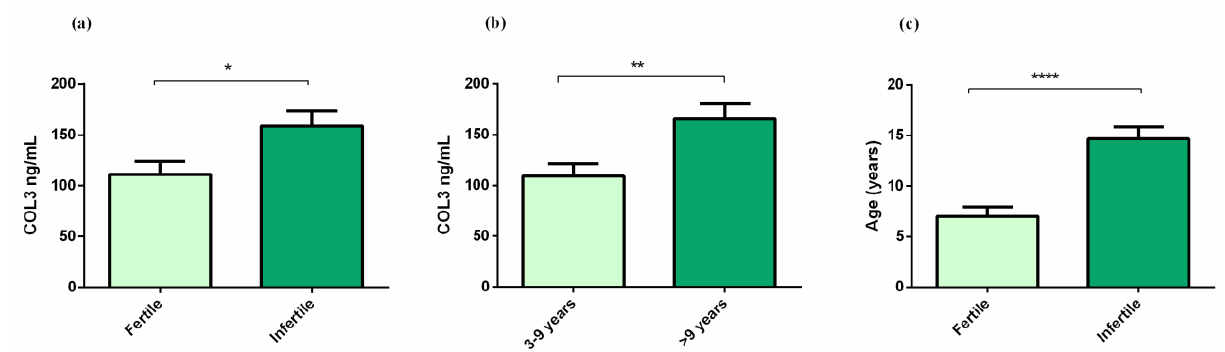
Figure 5. ( a ) Effect of fertility on serum type III collagen (COL3); ( b ) effect of age on serum COL3; ( c ) effect of age on fertility. Bars represent mean ± SEM. Asterisks indicate significant differences between fertility or age groups (* p < 0.05; ** p < 0.01, **** p < 0.0001).